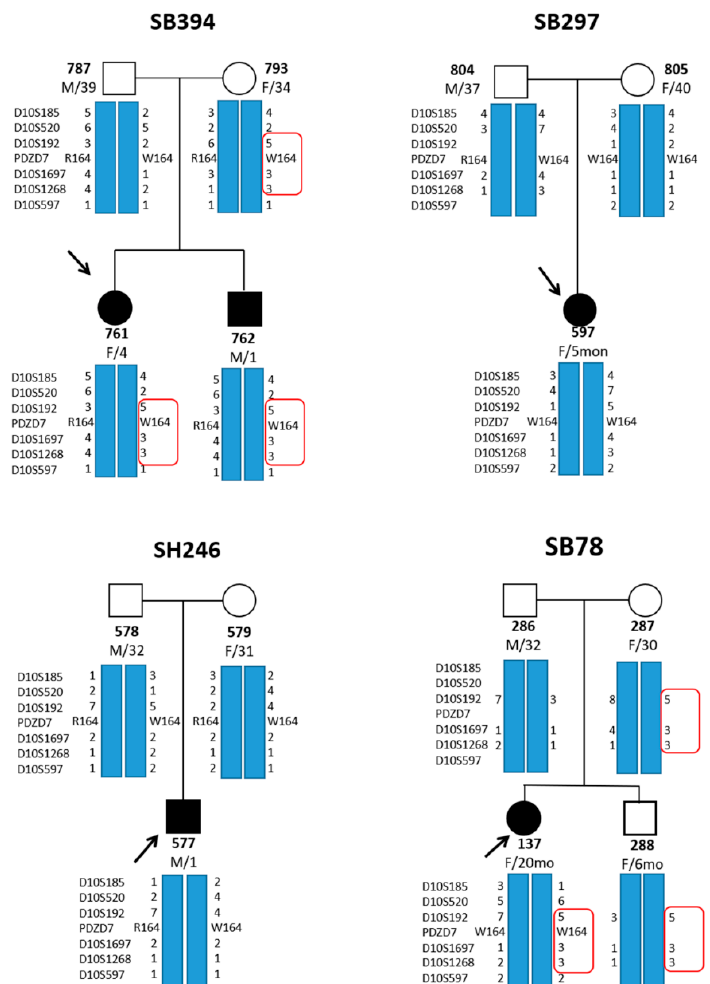
Figure 4. Pedigrees, showing p.Arg164Trp-linked haplotypes in the DFNB57 locus from four unrelated Korean families. The sequence of the microsatellite markers was as follows: D10S185, D10S520, D10S192, PDZD7, D10S1697, D10S1268, and D10S597. A red box indicates short stretches of common haplotype consisting of only three consecutive STR genotyping markers (D10S192, D10S1697, and D10S1268). Two unrelated probands (SB394–761 and SB78–137) carried an identical haplotype, and none of the controls presented this haplotype. Solid shapes with arrows denote the